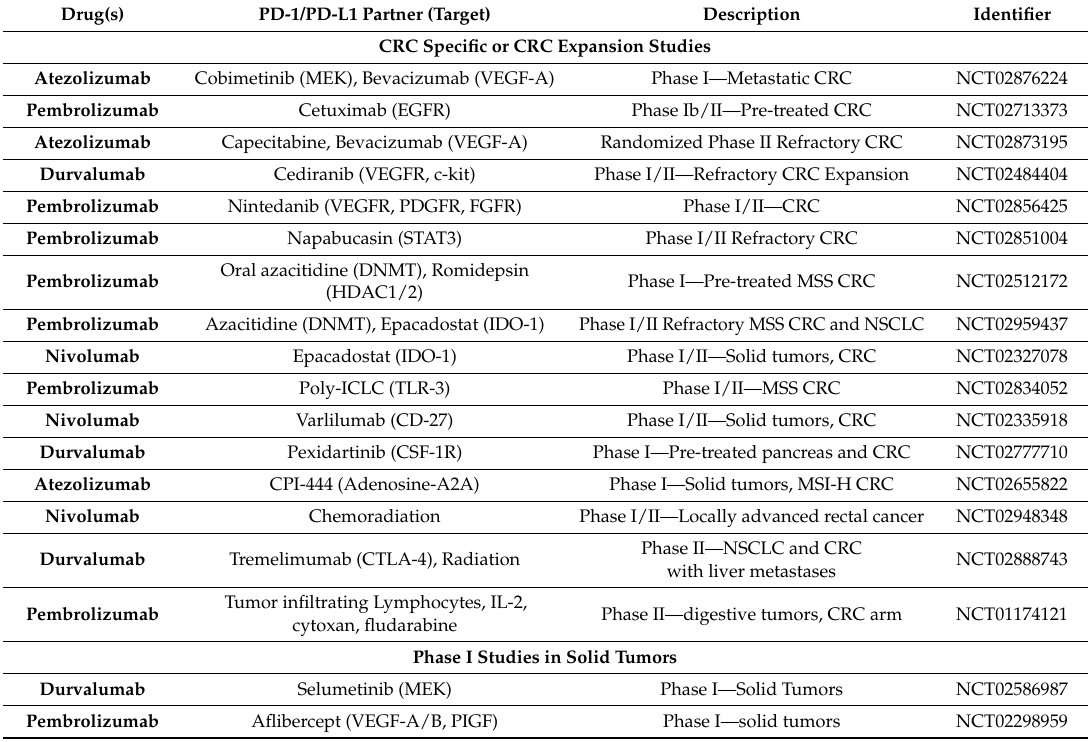
Table 3. Combinatorial immunotherapy trials in